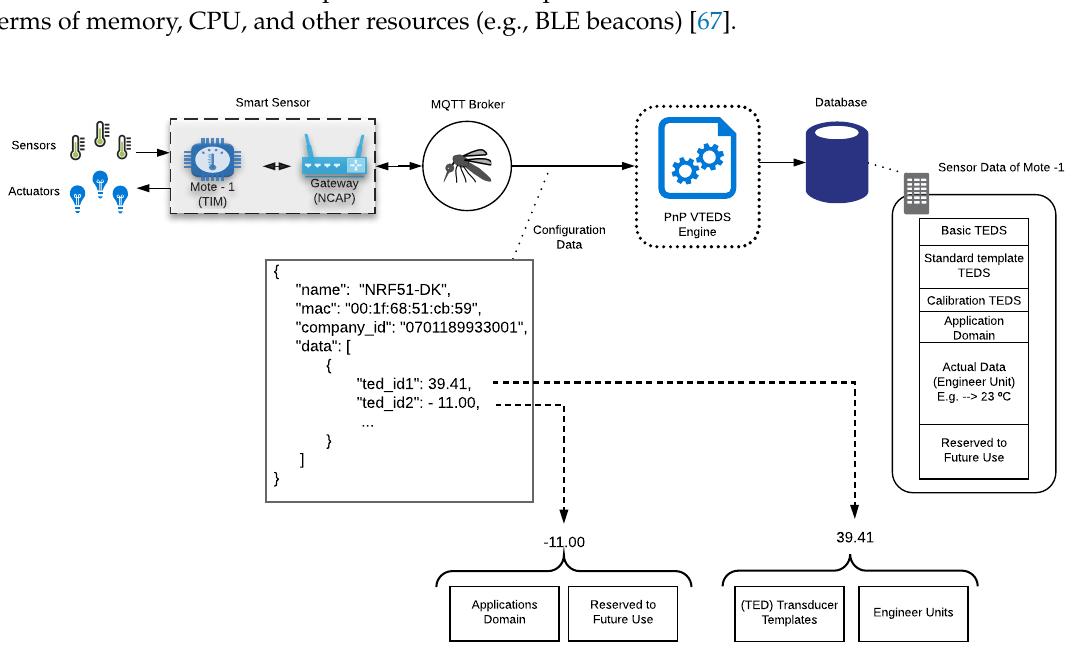
Figure 9. Metadata structure and collection from a smart